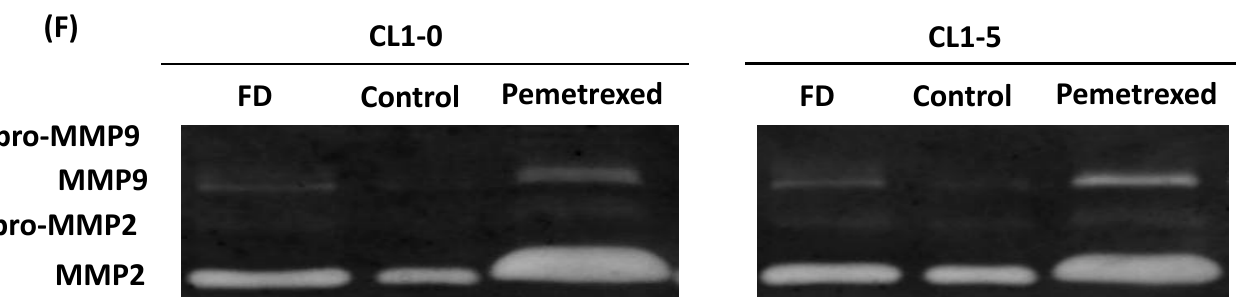
Figure 2. Disruption of cytosolic folate integrity enhances NSCLC cell invasiveness by upregulating MMP activities. ( A ) Typical Matrigel images and NSCLC cell invasiveness with or without disruption of cytosolic folate integrity were compared. Cells that had invaded through the matrix gel were quantified according to the number of stained cells through Liu’s stain method in all fields of each multiwell cell culture insert. The invasive cells were stained purple. Scale bar (blue): 100 μ m. ( B ) Magnitudes of migration ability changes (expressed as folds) of pemetrexed-treated NSCLC cell lines. ( C ) Magnitudes of migration ability change (expressed as folds) of folate-deprived NSCLC cell lines. ( D ) The mRNA expressions of MMPs, including MMP1, MMP2, MMP7, and MMP9 induced by pemetrexed (30 ng/mL) for 1, 2, or 3 weeks in CL1-0 or CL1-5 cells were determined through RT-qPCR (black bar: control, gray bar: pemetrexed for 1 week, dark gray bar: pemetrexed for 2 weeks, and light gray bar: pemetrexed for 3 weeks). ( E ) CL1-0 cells under FD treatment for 2, 3, or 4 weeks exhibited increased MMP1, MMP2, and MMP9 mRNA expressions, but no significant increases were observed in folate-deprived CL1-5 cells (black bar: control, gray bar: FD for 2 weeks, dark gray bar: FD for 3 weeks, and light gray bar: FD for 4 weeks). ( F ) Gelatinase activities of folate-deprived or pemetrexed-treated (30 ng/mL) CL1-0 or CL1-5 cells were also analyzed through gelatin-containing zymography. * p < 0.05; ** p < 0.01; *** p < 0.001.